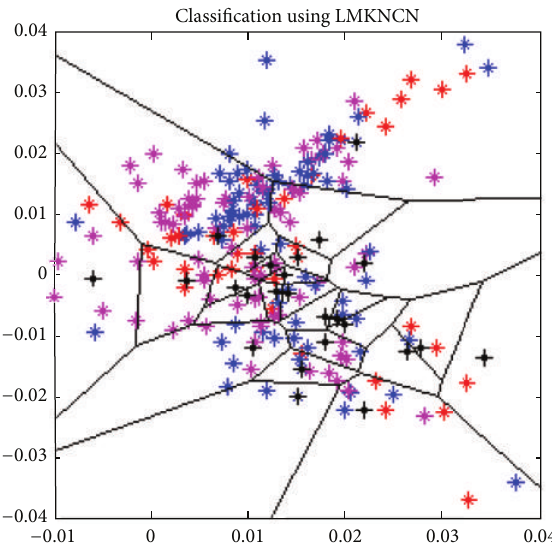
Figure 5: Classification result using